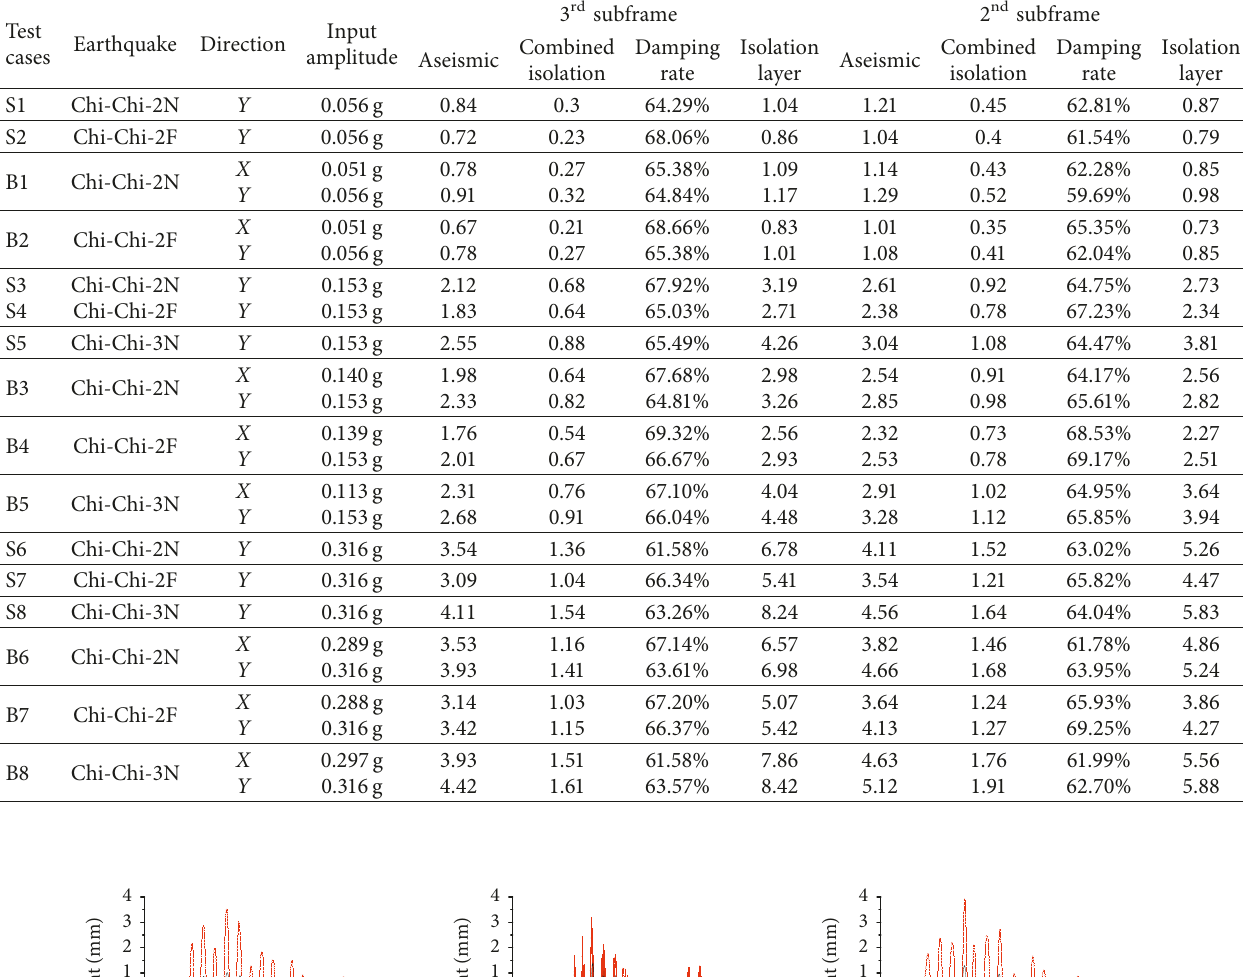
Table 5: Displacement response and damping rate of the subframe top floor (mm).